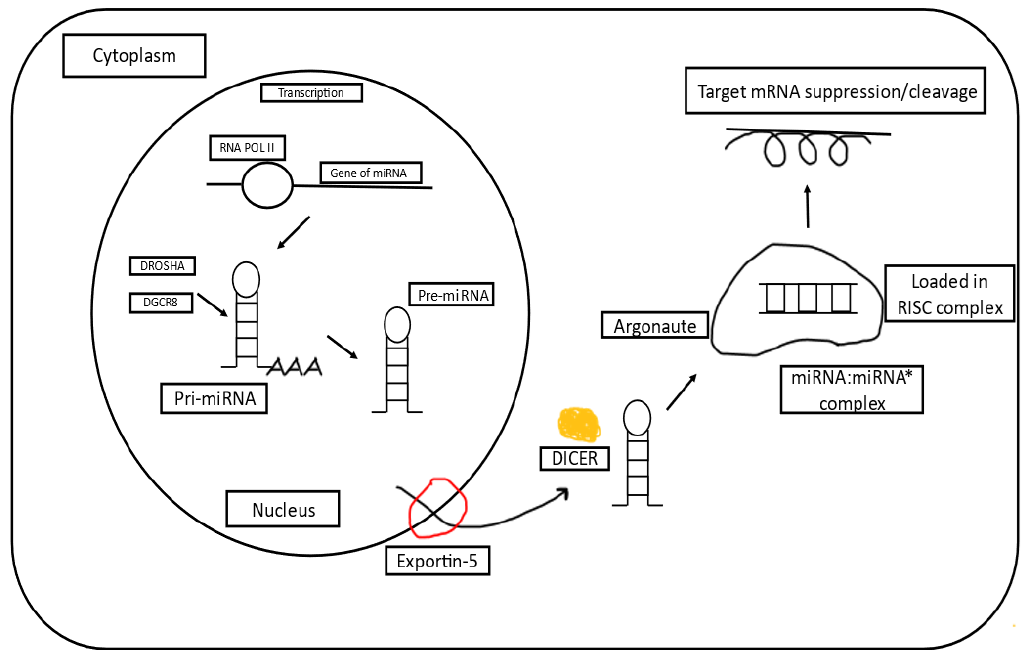
Figure 1. A basic overview of miRNA biogenesis [15]. RNA POL II: RNA polymerase II; DGCR8: DGCR8 microprocessor complex